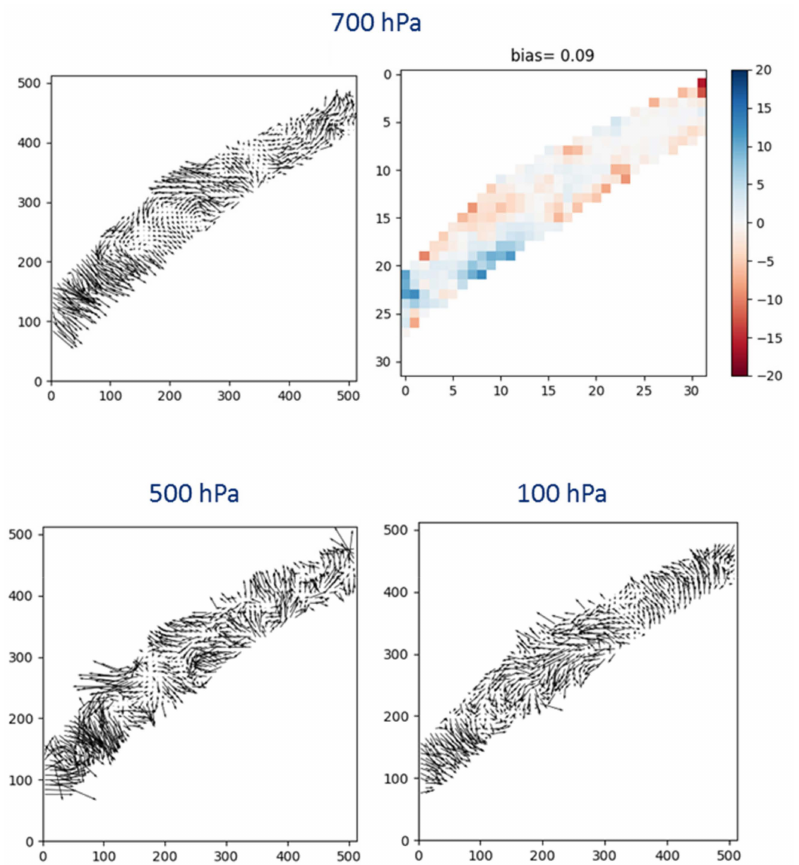
Figure 9. Example of 3D Infrared Atmospheric Sounding Interferometer (IASI) winds extracted at 700, 500 and 100 hPa from Metop A and Metop B consecutive orbits over northern polar areas on 4 July 2018 at 00:46:09 UTC. Speed bias against forecast fields is shown for the 700 hPa retrieval. Data are projected on polar stereographic grid centered on North Pole and have a nominal resolution of 20 km. X and Y axis units correspond to grid